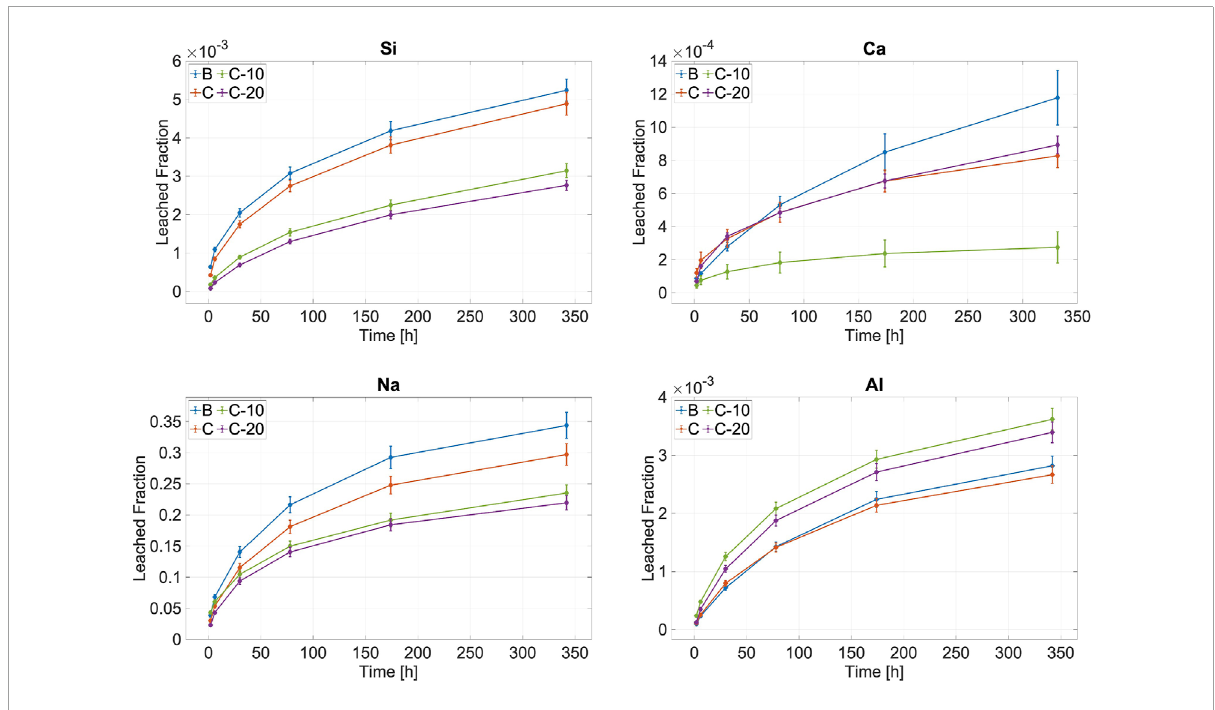
FIGURE 10 Cumulative release curves. The uncertainties bars on low values are within the marker size.